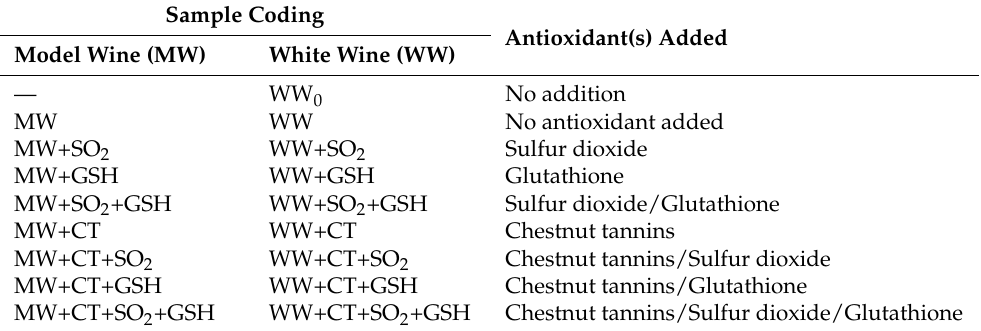
Table 6. Experimental plan and sample coding according to